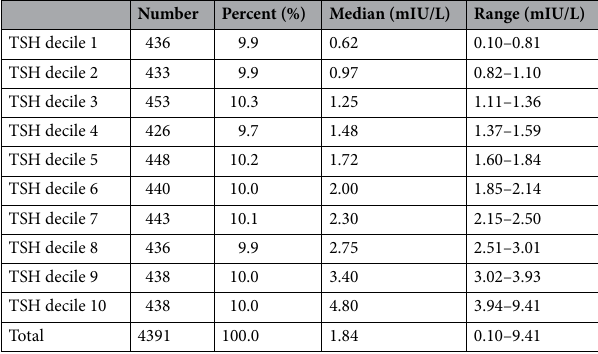
Table 2. Preoperative serum TSH levels decile. TSH